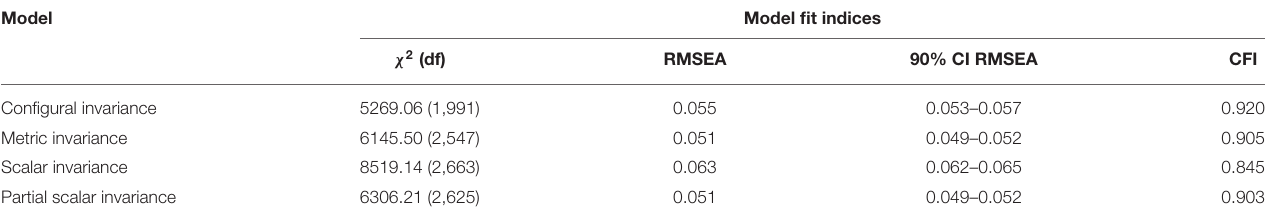
TABLE 4 | Measurement invariance models and goodness-of-fit indexes of multigroup analyses of the 5Cs across countries.